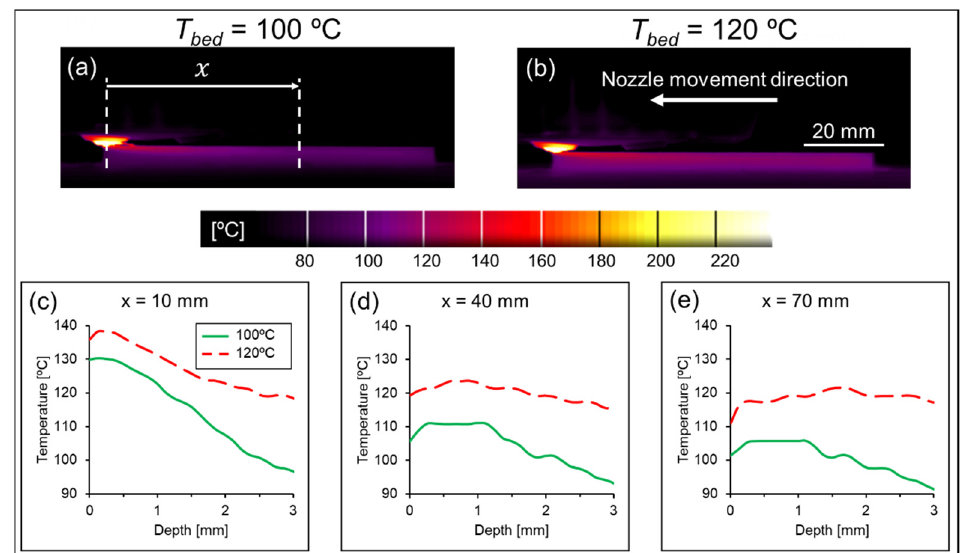
Figure 20. Comparison between the temperature profiles of specimens printed at a bed temperature of ( a ) 100 °C and ( b ) 120 °C. The nozzle moved longitudinally during the measurement. The profiles were measured at ( c ) 10 mm, ( d ) 40 mm and ( e ) 70 mm from the nozzle.